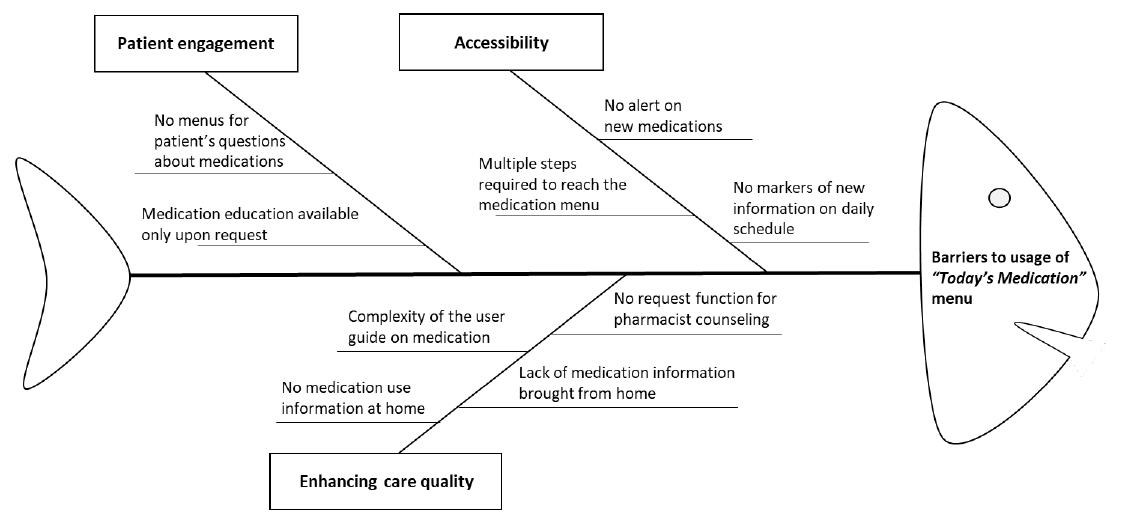
Figure 2. Fishbone diagram outlining barriers to usage of Today’s Medication.